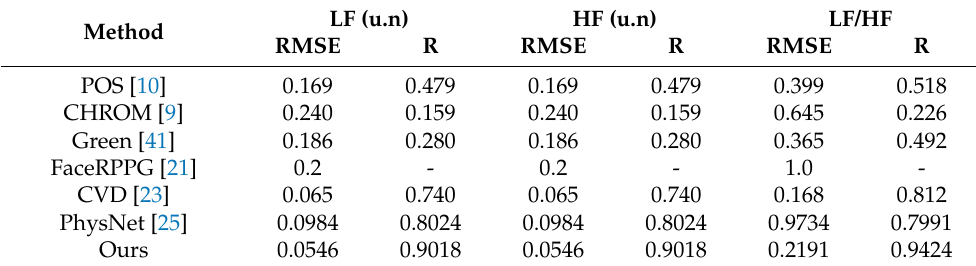
Table 3. The result of frequency-domain metrics on the UBFC-rPPG dataset.